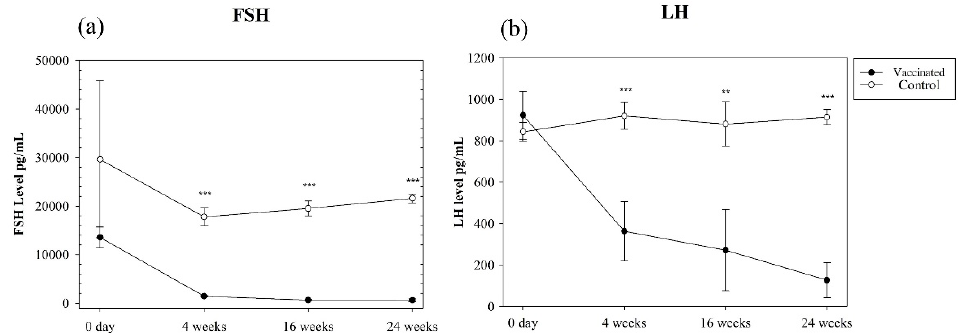
Figure 3. Serum ( a ) follicle-stimulating hormone (FSH) and ( b ) luteinizing hormone (LH) concen- trations (pg/mL) in the vaccinated and control groups. The vaccinated group had significantly lower